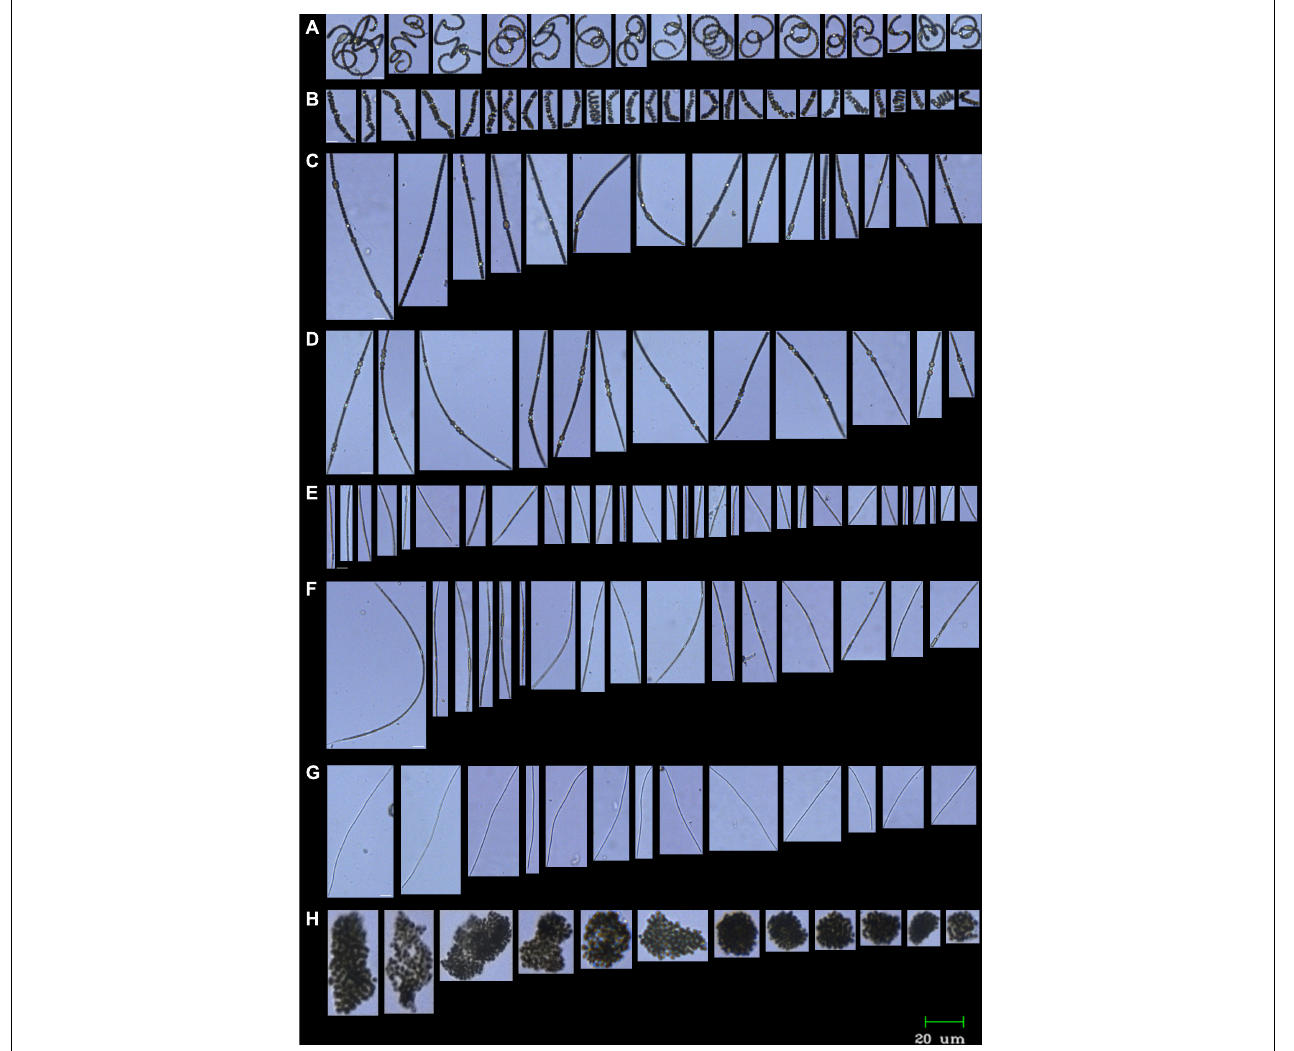
FIGURE 2 | FlowCAM image galleries of most abundant cyanobacteria in River Ural in August 2019. Samples preserved with 0.5% glutaraldehyde; × 10 objective, 100 µ m flow cell. (A,B) Curved Dolichospermum filaments ( A Dolichospermum cf. flos-aquae , B Dolichospermum cf. compactum ); (C) straight Dolichospermum filaments ( Dolichospermum cf. macrosporum ); (D) Sphaerospermopsis aphanizomenoides ; (E) Cylindrospermopsis raciborskii ; (F) Cuspidothrix issatschenkoi ; (G) Pseudanabaena limnetica ; (H) Microcystis sp. Scale bar, 20 µ